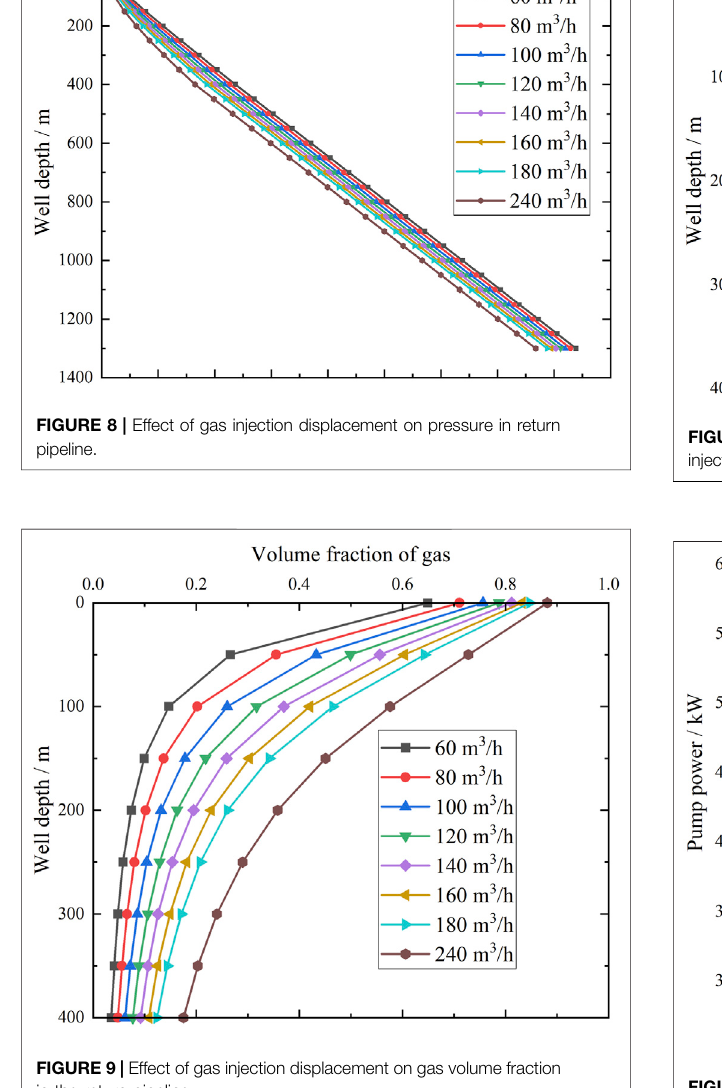
FIGURE 11 | Effect of gas injection displacement on pump lifting